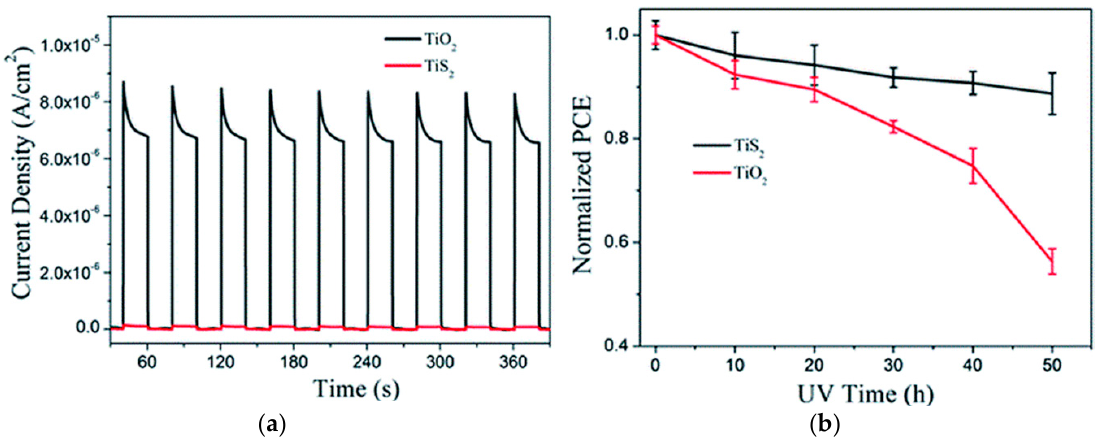
Figure 9. ( a ) Ultraviolet photocatalytic activity for decomposition of water in Na 2 SO 4 solution by using TiO 2 and on TiS 2 film on FTO glass as photoanodes; ( b ) Long-term UV light stability of the PSCs with TiO 2 or TiS 2 film as the ETLs